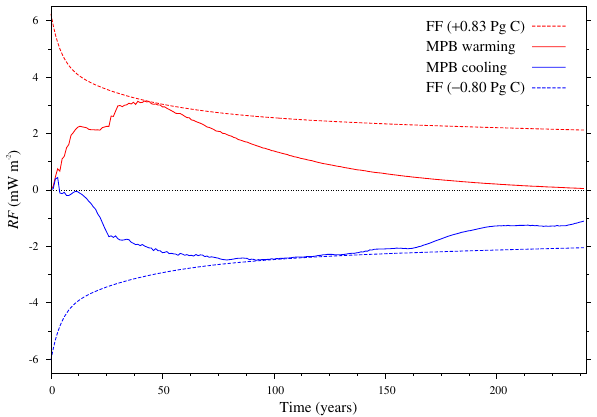
Figure 7. Comparison of the strongest warming and cooling ra- diative forcing (RF) responses from the MPB Peak outbreaks with the RF from a pulse of fossil fuel (FF) CO 2 emissions (in milli- Wm − 2 ). The MPB RF were computed for an outbreak area of 18.1Mha; the warming response came from the NEonly scenario at the central location and the cooling response from the NE-LC scenario at the northern